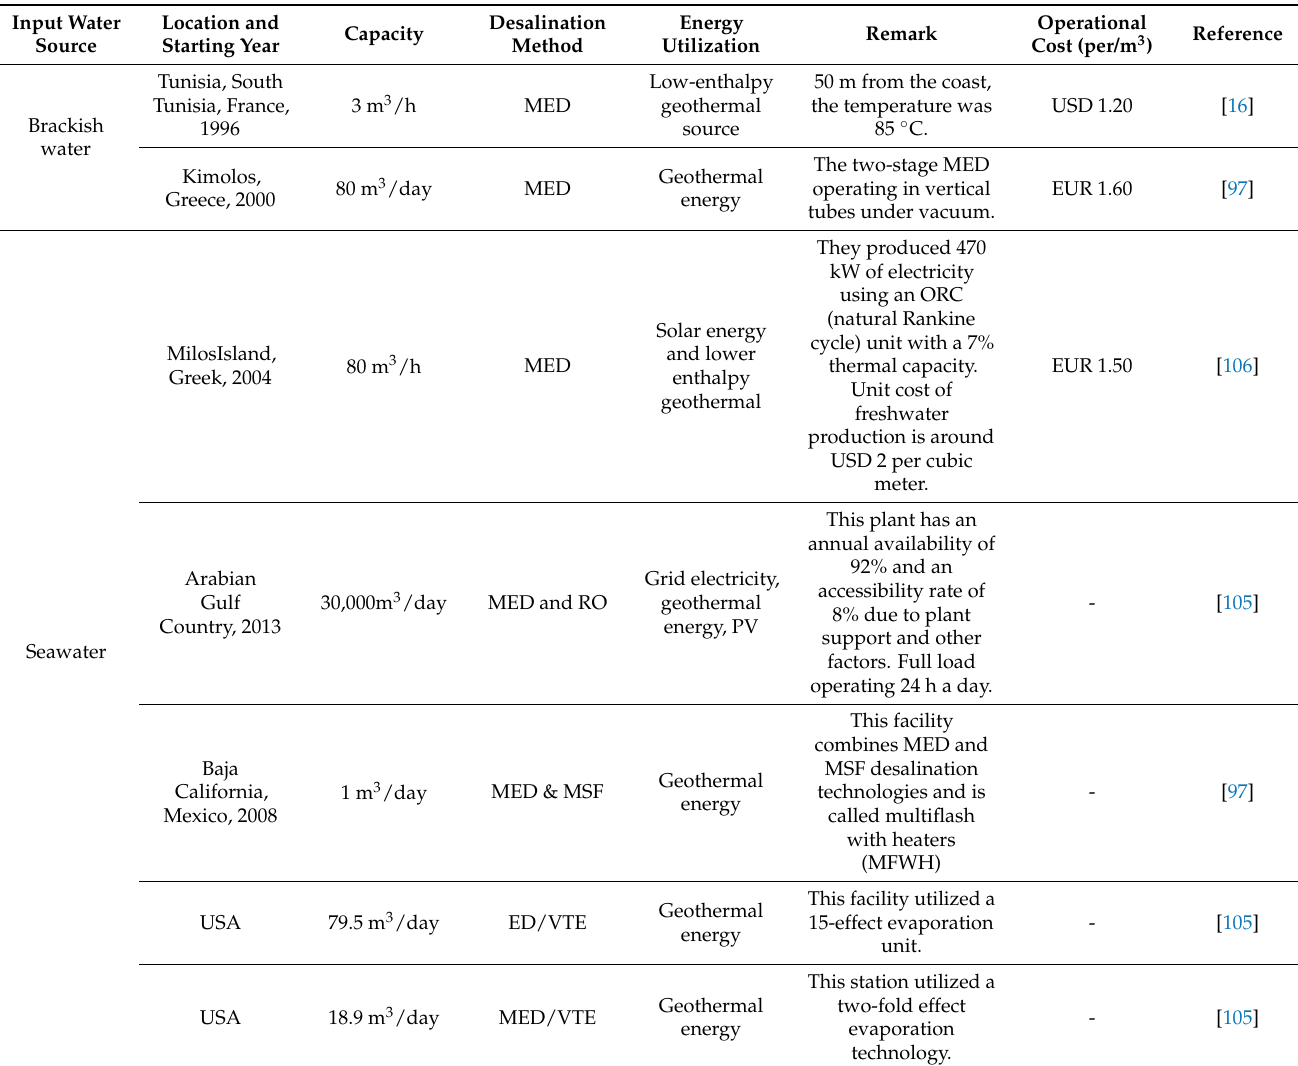
Table 2. Various desalination stations employing geothermal energy